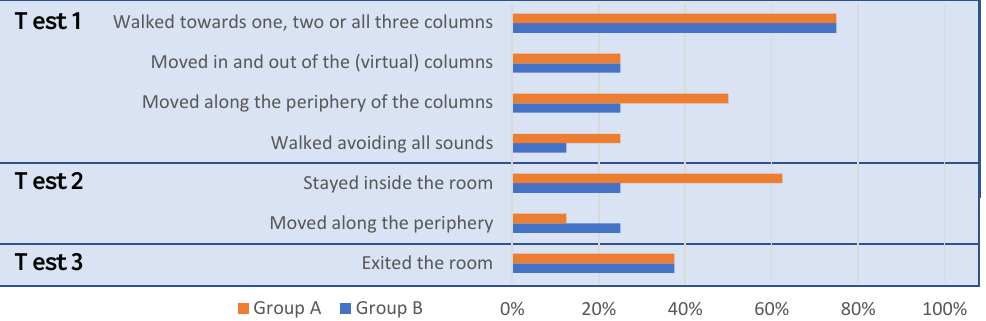
Figure 8. Common subject behavior.